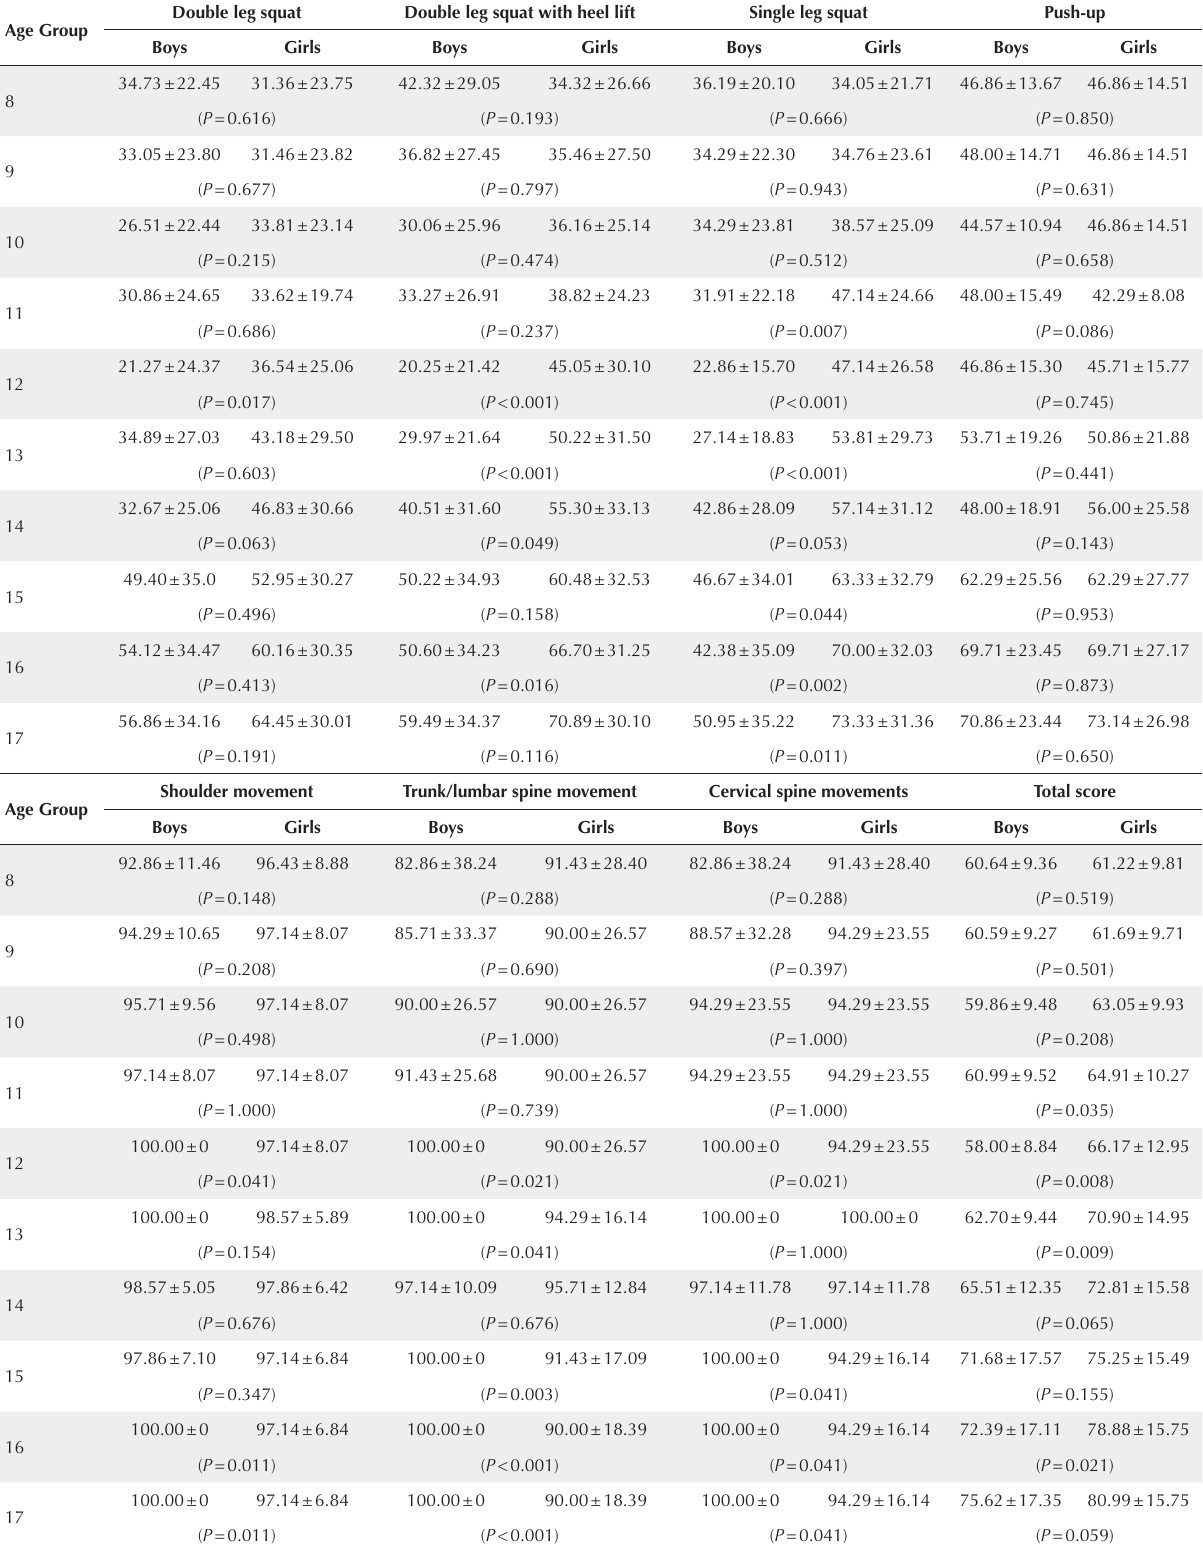
Table 3. Fusionetics Scores During Each Task and Total Fusionetics Scores of all Seven Tasks by Age Group Double leg squat Double leg squat with heel lift Single leg squat Age Group